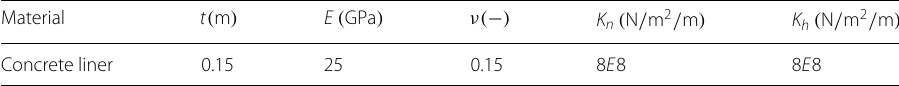
Table 5 Liner parameters design used in simulation by FLAC 3D